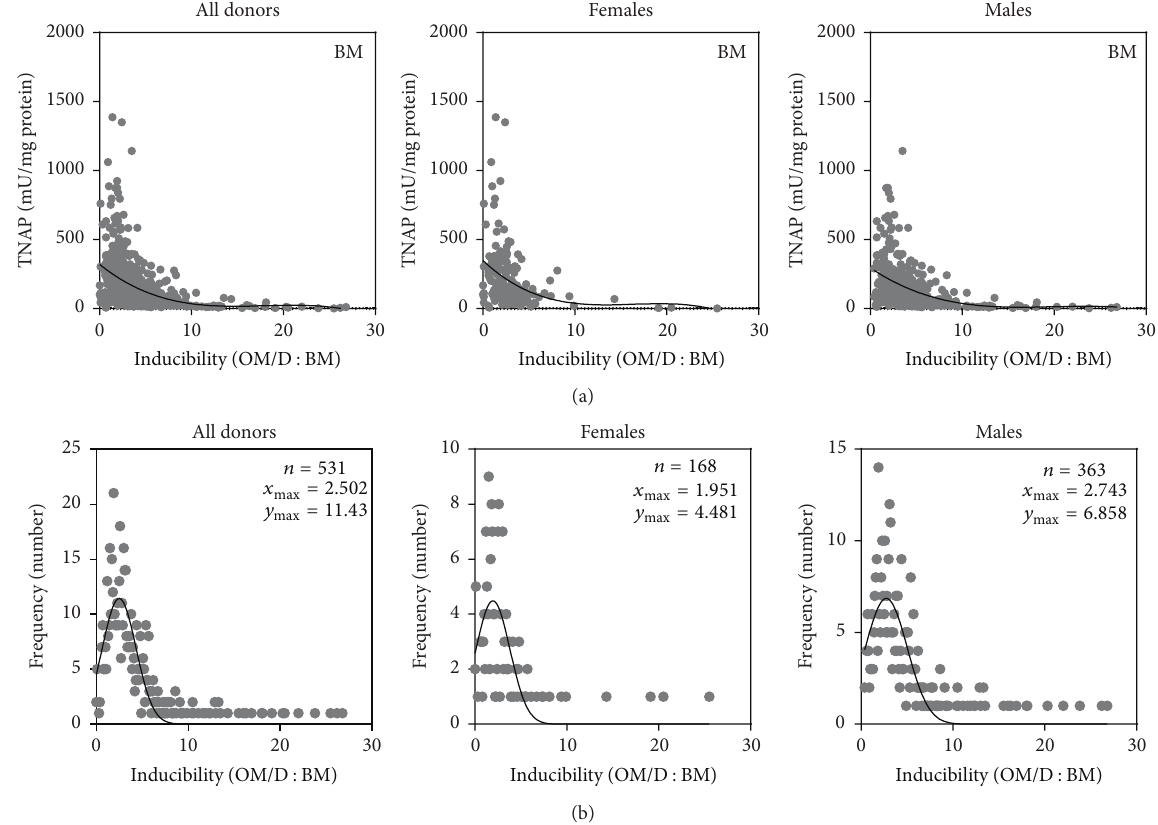
Figure 2: Correlation of TNAP inducibility to endogenous TNAP activity and frequency of certain inducibility values. hBMSC in passage 1 were plated in BM (basic medium) onto TCPS (= P2). From day 4 after plating, the cells were cultured either in BM or in OM/D (osteogenic differentiation medium) and analyzed at day 15 after plating for TNAP activity as described. The inducibility of TNAP activity (TNAP in OM/D: TNAP in BM) was calculated from individual donor data pairs and plotted against endogenous TNAP activity (a). The black line indicates a cubic curve fit; 𝑅 -square values are given in Table 2; 𝑛 = 531 (all donors), 𝑛 = 168 (females), and 𝑛 = 363 (males). By plotting the number of donors with a given TNAP inducibility, the frequency of certain inducibility value was figured out (b). The data points were analyzed by nonlinear curve fit and resulted in a Gaussian distribution. The peak characteristics ( 𝑥 max , 𝑦 max ) are indicated in the graphs; 𝑛 = 531 (all donors), 𝑛 = 168 (females), and 𝑛 = 363 (males).